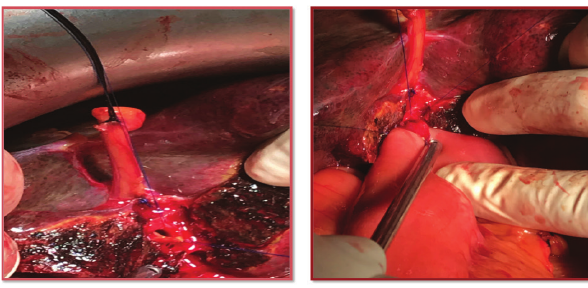
Figure 2. Segment three-duct and bilioenteric anastomosis